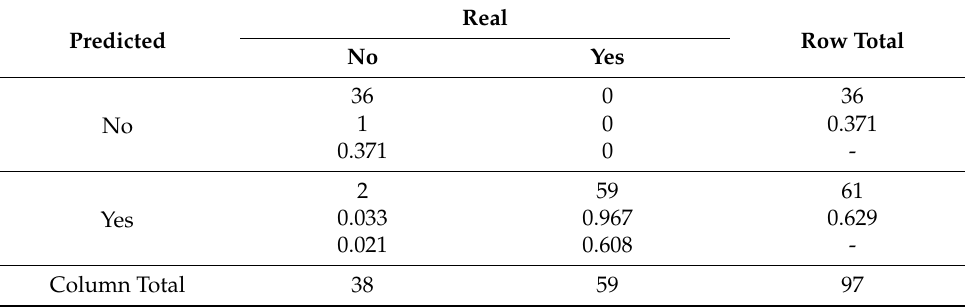
Table 2. Confusion matrix. Random Forest model.